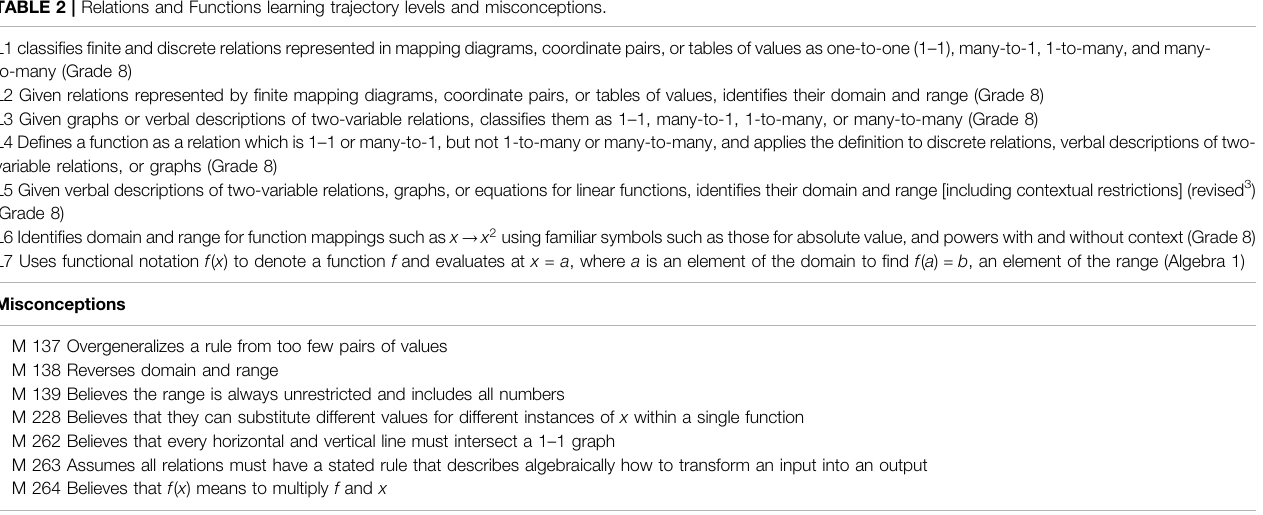
TABLE 2 | Relations and Functions learning trajectory levels and misconceptions.